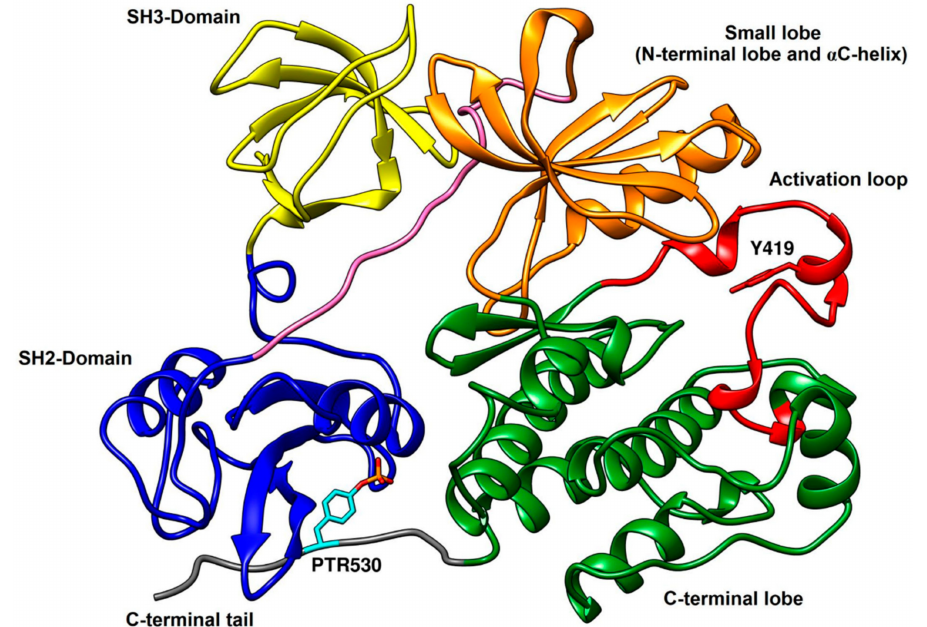
Figure 1. X-ray structure of c-Src in inactive conformation. The di ff erent domains are shown: SH1 domain comprising of small lobe (orange), activation loop (red), C-terminal lobe (green); SH2 domain (blue); SH3 domain (yellow); linker (pink); C-terminal tail (grey). Two phosphorylation sites Y419 and Y530 are